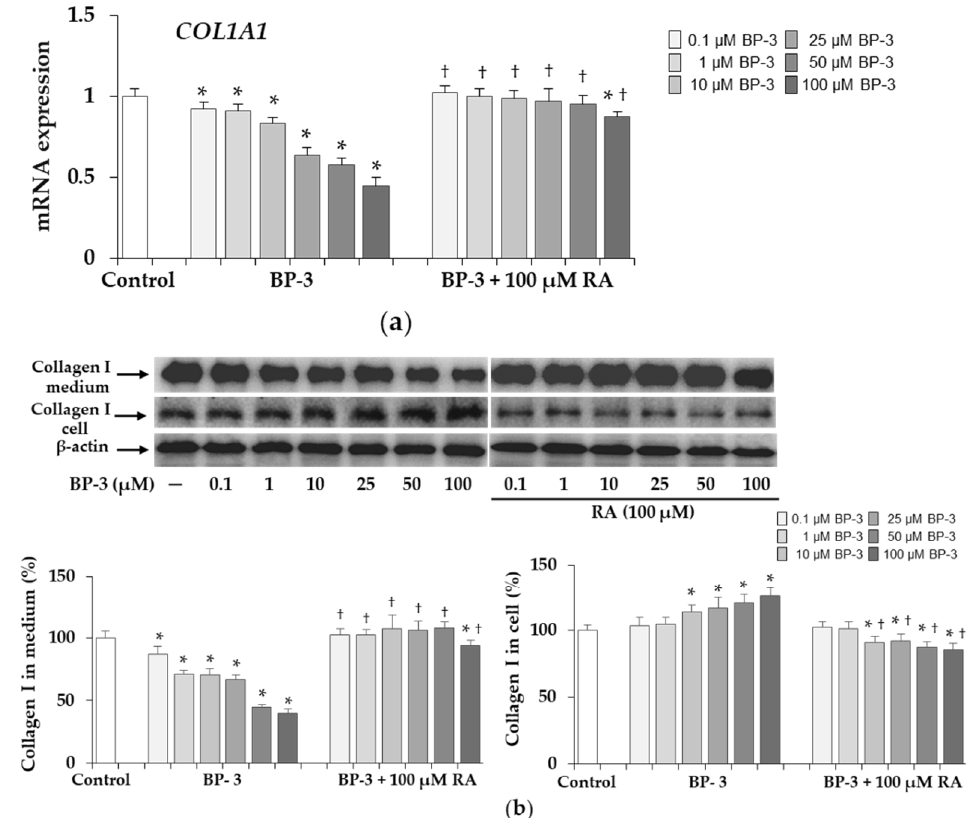
Figure 3. The expression of collagen type I at the mRNA ( a ) and protein ( b ) levels in fibroblasts treated with benzophenone-3 (BP-3) alone and in combination with rosmarinic acid (RA). The expression of COL1A1 gene was assayed by real-time PCR, values represent the mean ± SD of three experiments ( a ). Representative gels of Western blotting (β-actin was used as cell protein loading control); densitometry values represent the mean ± SD of three experiments. The data are expressed as a percentage of the control sample assumed as 100% ( b ); * p < 0.05 vs. control (untreated cells); † p < 0.05 vs. respective samples treated with BP-3 alone.